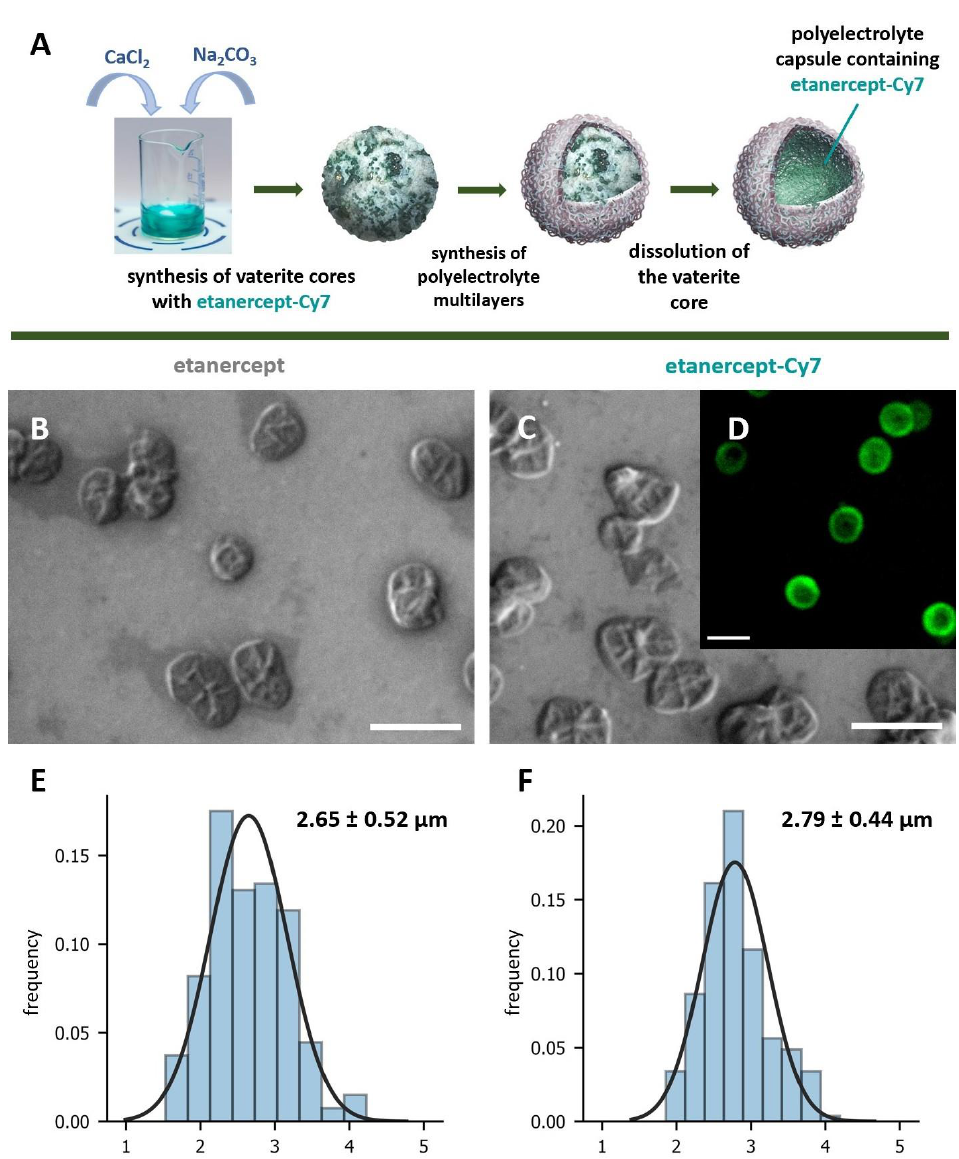
Figure 1. Scheme of etanercept-Cy7 encapsulation in polyelectrolyte microcapsules ( A ). Typical SEM images of microcapsules with etanercept ( B ) and etanercept-Cy7 ( C ). CLSM image of typical polyelectrolyte microcapsules with etanercept-Cy7 ( D ). Size distribution with Gaussian fit of microcapsules with etanercept ( E ) and etanercept-Cy7 ( F ) in aqueous solution. The diameter was determined from SEM images of 200 microcapsules. The scale bar is 5 µm.